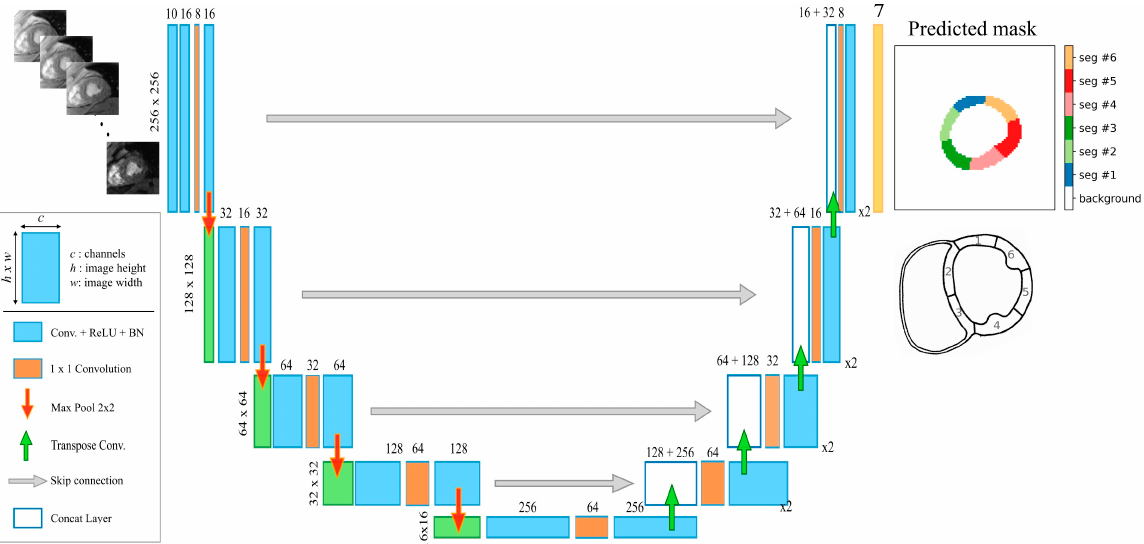
Figure 1. The proposed U-Net model architecture for the automatic segmentation of multi-echo gradient-echo images.